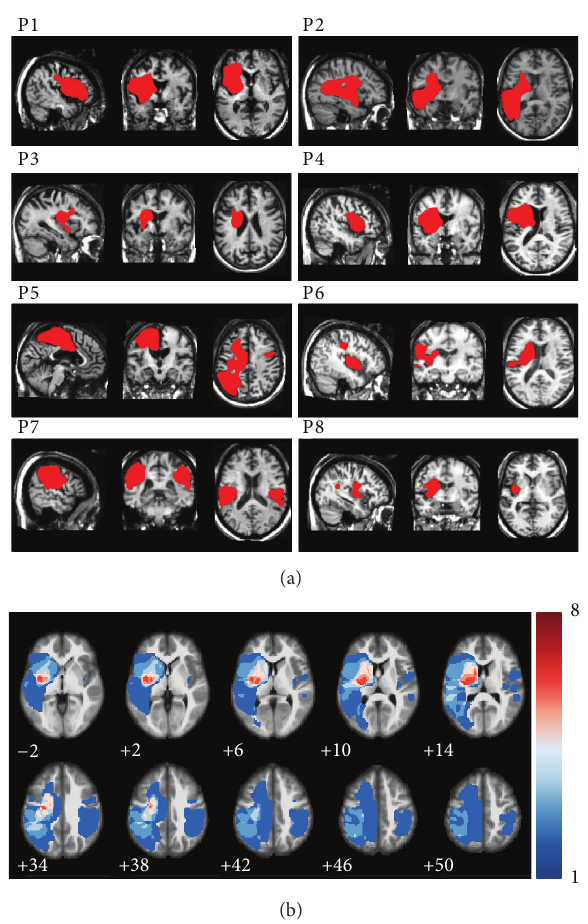
Figure 2: (a) Representative images from the normalized T1-weighted anatomical scans are shown for each patient; lesion delineations are shown in red. (b) A lesion frequency overlay for all 8 participants shown as a color-map overlaid on a template anatomical image. Colors represent the number of patients with a lesion at each voxel as indicated by the color